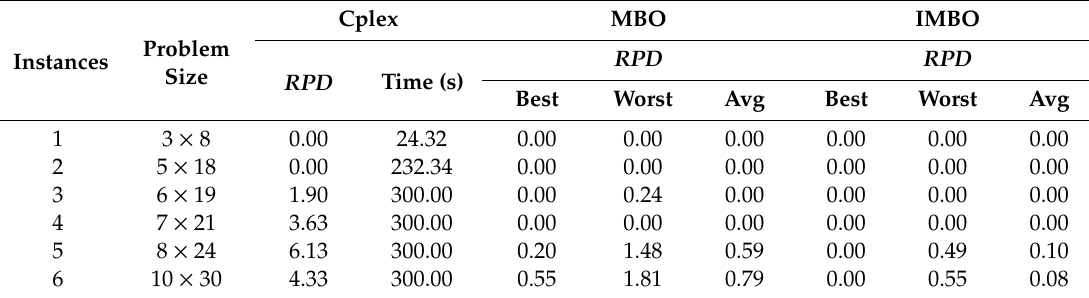
Table 10. Computational results by the Cplex, MBO and